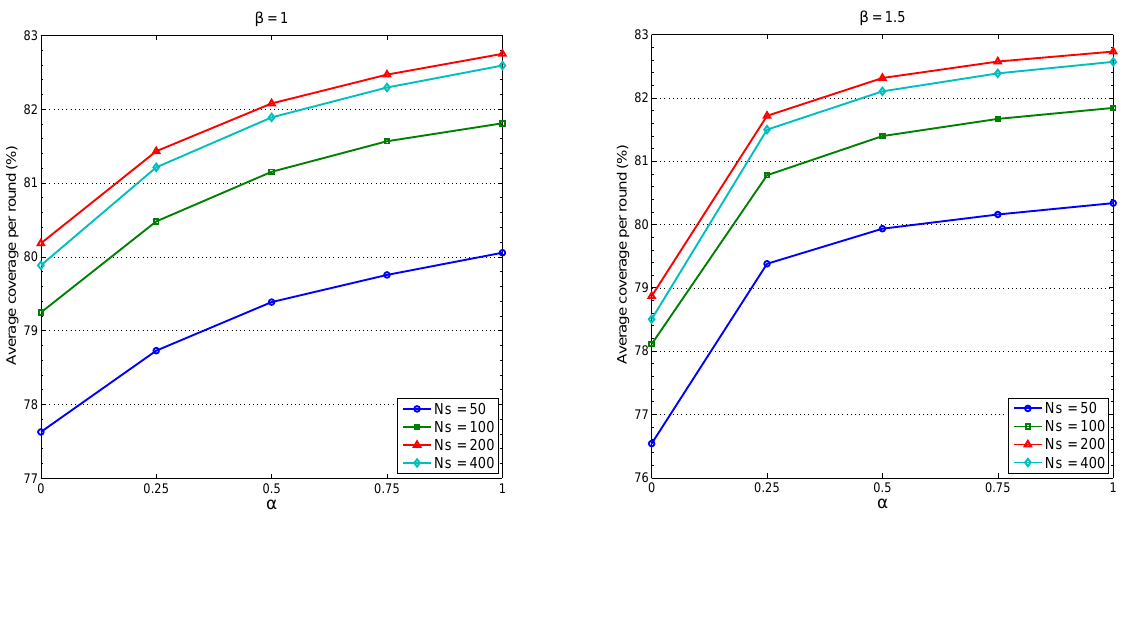
Figure 10. Average coverage per round versus α with β = 1 . 0 (left) and with β = 1 . 5 (right).